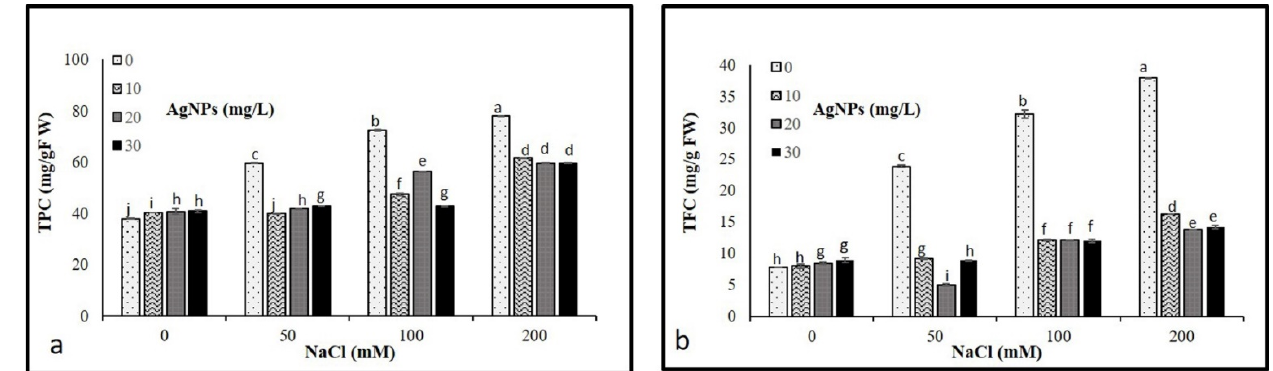
Figure 8. Non-enzymatic antioxidant compounds ( a ) TPC and ( b ) TFC in Maerua oblongifolia leaves under salt stress and application of silver nanoparticles. Means ± SD for each treatment followed by the same letters are not significantly different according to the Duncan’s test ( p ≤ 0.05).